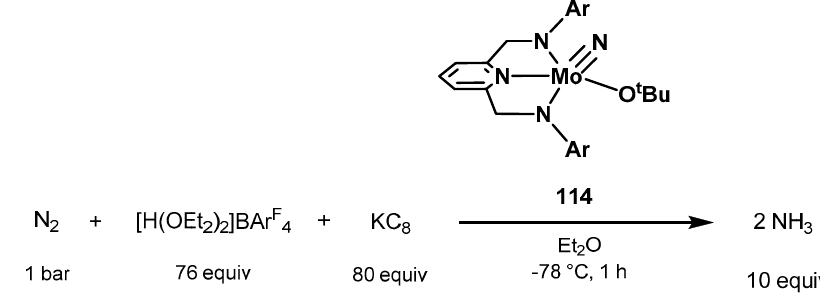
Figure 7. Szymczak’s Fe(II)-NNN pincer complex 115 coordinates one to two equivalents of hydrazine [722].